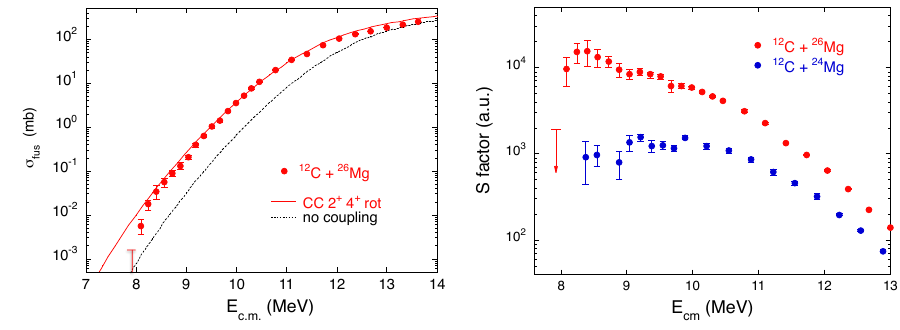
Figure 4. Fusion excitation function measured for 12 C + 26 Mg (preliminary data) compared to CC calculations (left) and S factor of the two systems (right panel).